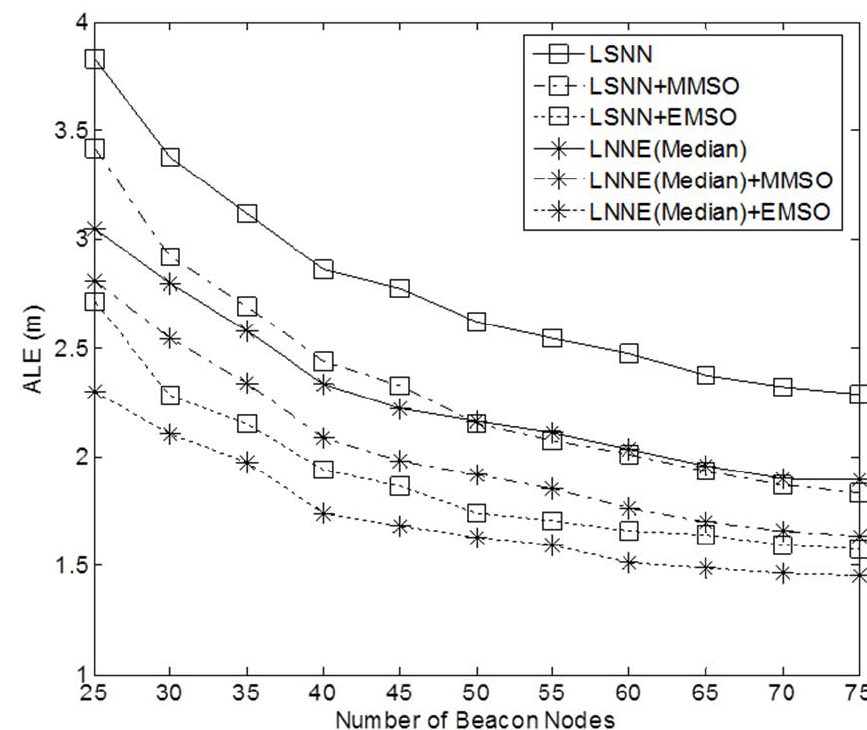
Figure 12. Performance of refinement algorithms under different beacon ratios ( N = 250, beacon ratio = 0.1–0.3, no coverage